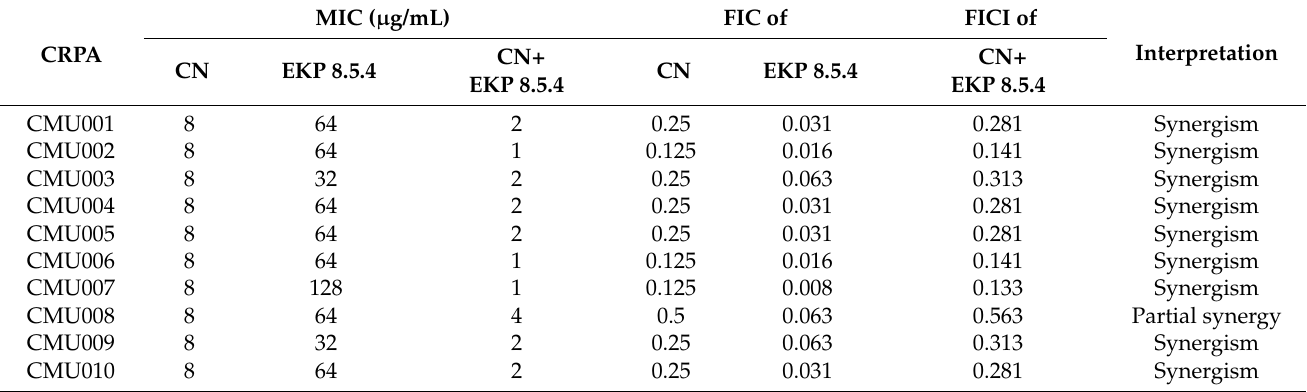
Table 6. Combination effect of gentamicin and EKP 8.5.4 extract against CRPA.